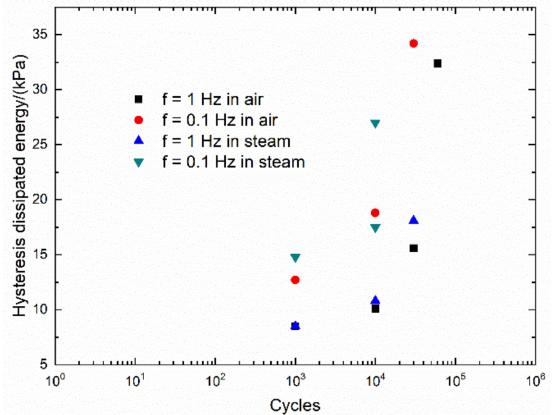
Figure 8. Tensile curve of 2D woven self-healing Hi-Nicalon TM SiC / [SiC-B 4 C] composite at 1200 ◦ C.